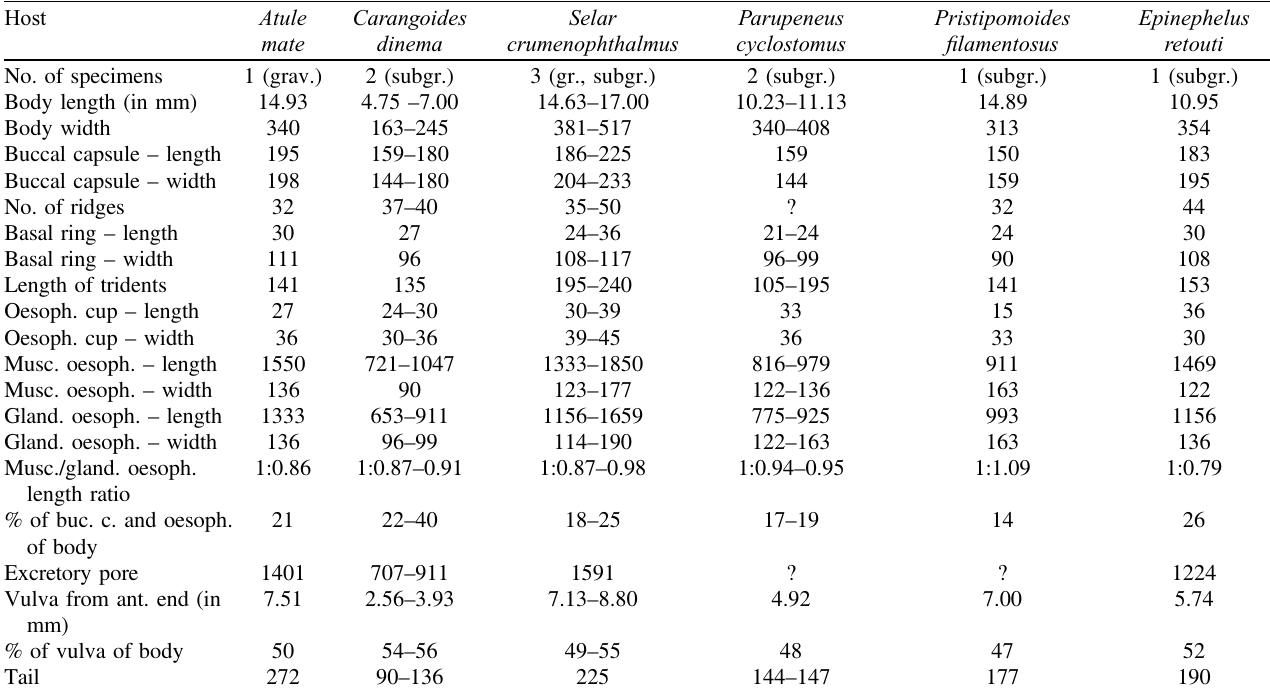
Table 2. Comparison of measurements of Camallanus carangis females from marine fi shes in New